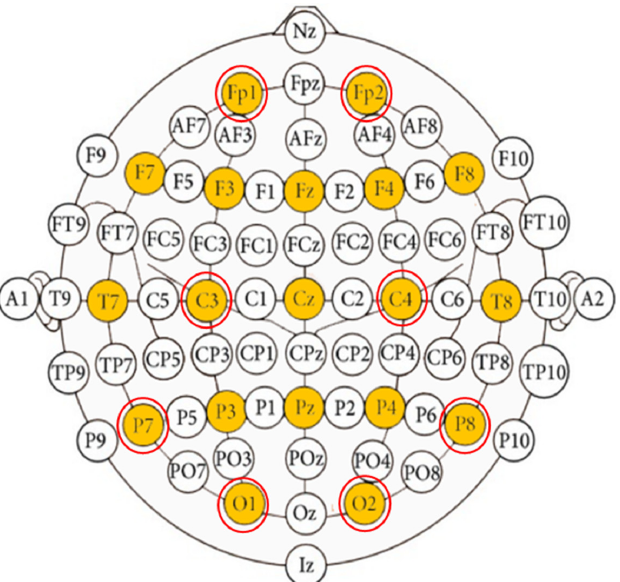
Figure 2. The placement of OpenBCI cap electrodes. Where yellow circles indicate the electrodes on the OpenBCI EEG Electrode Cap, the electrodes of Our project are represented in red circles. Each volunteer completed ten trials. Each trial consisted of one minute of eye-open recording and one minute of eye-closed recording for measurement. Because the actual collected EEG data are easily polluted by noise, the EEG signals recorded directly from scalp electrodes cannot accurately represent the brain’s neural signals. It is necessary to preprocess and de-noise the original EEG data to reduce or eliminate the influence of ar- tifacts as much as possible.